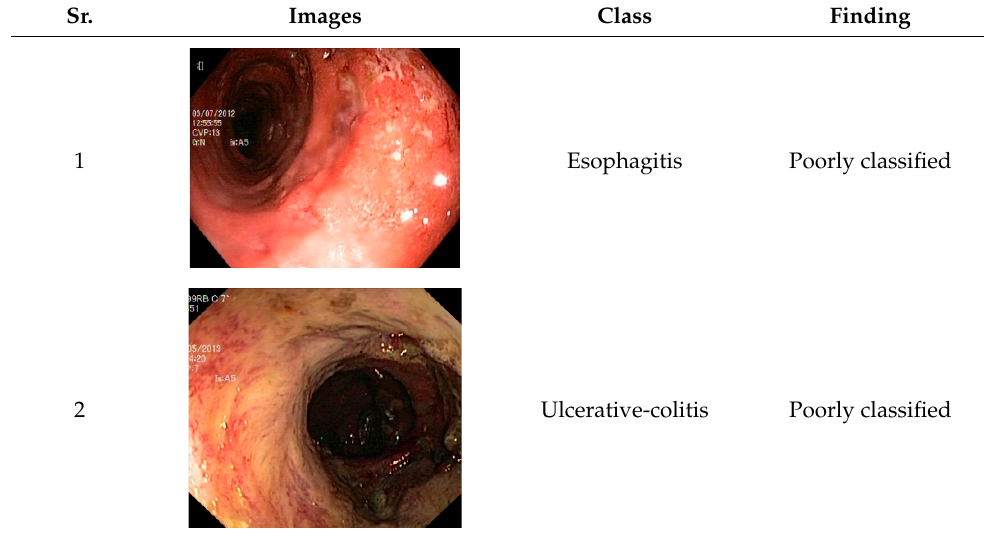
Table 8. Sample of classified images by Mobilenetv2. Sr.